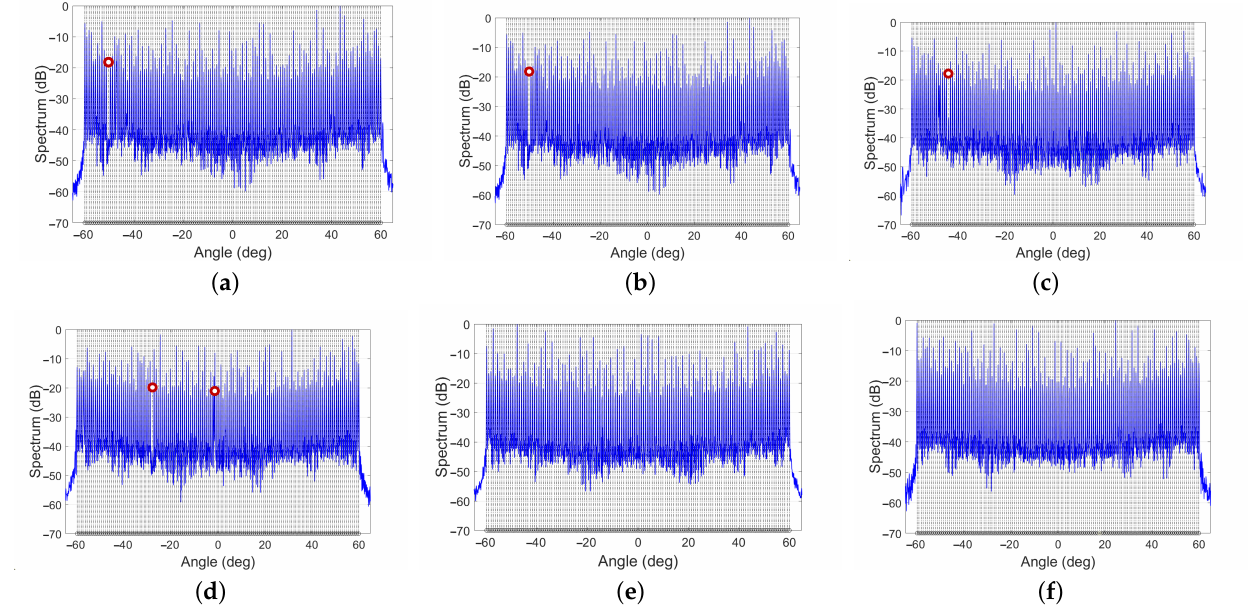
Figure 8. Simulation diagram of DOA estimation for six sparse arrays. The red circle indicates that there is a wrong spectral peak at this position. ( a ) NA. ( b ) ANA. ( c ) MISC. ( d ) OS-ENA. ( e ) TS-ENA. ( f )